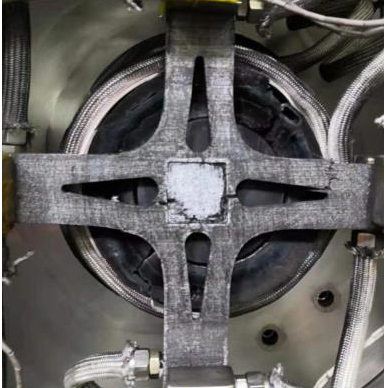
Figure 22. Cruciform specimen of C/C composites.